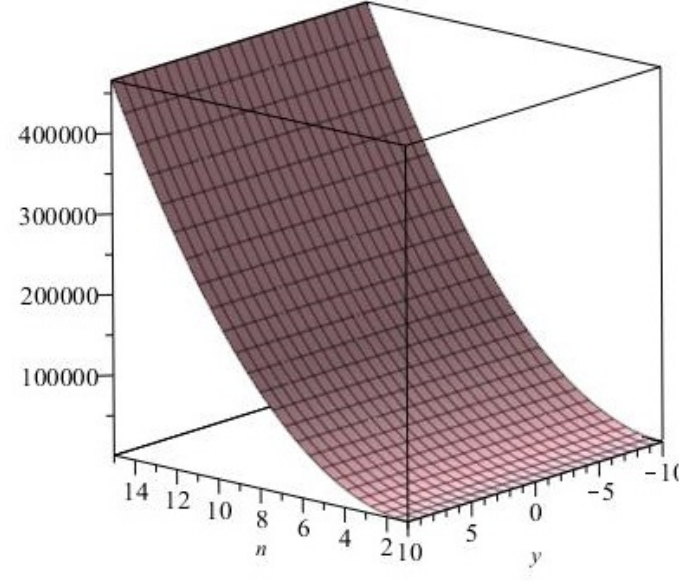
Figure 4. The graphical representation of the Eccentric connectivity